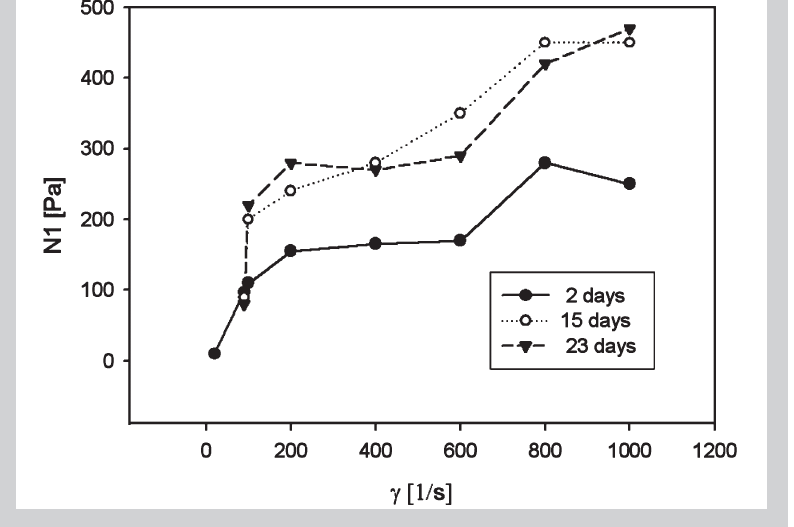
Figure 11: Measurement of viscoelastic properties shows a great scatter of data in low con- centrated solutions like in this plot of first normal stress difference, N [Pa], in 1 dependence of shear